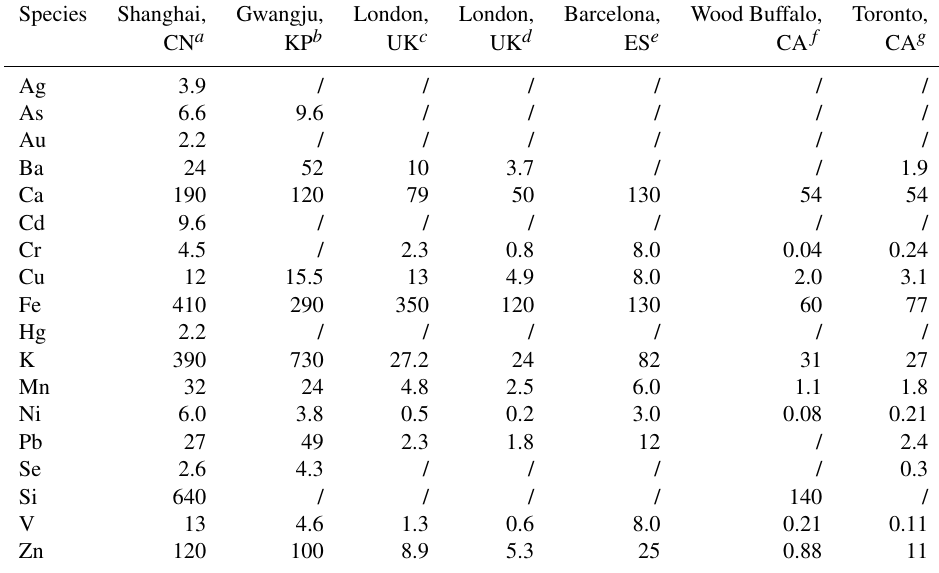
Table 1. Overview of long-term and high-time resolution measurements of ambient trace elements concentrations (ngm − 3 ) in fine particles.